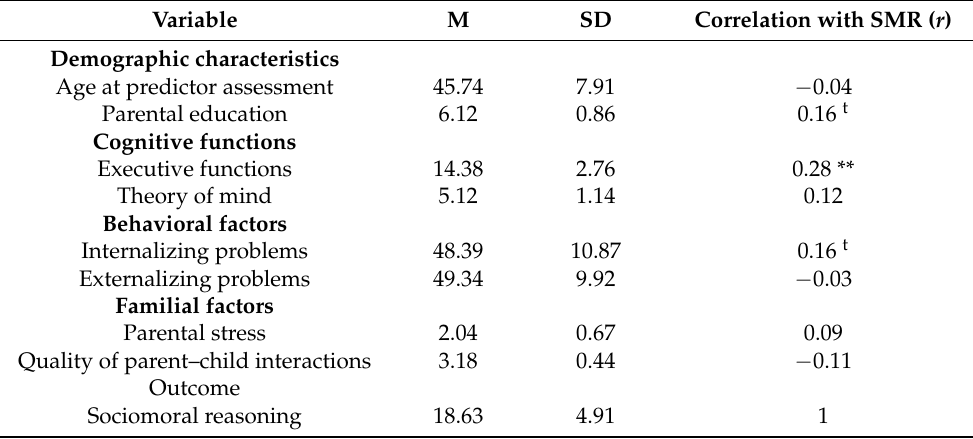
Table 2. Sample characteristics and main variable outcomes.